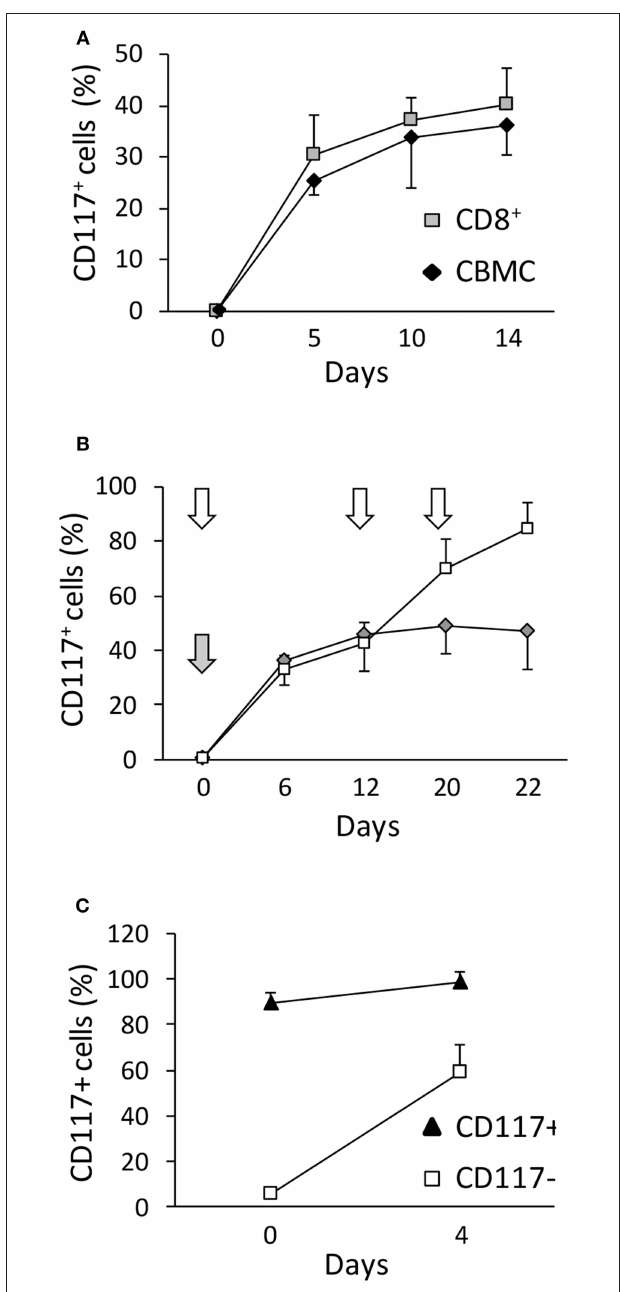
FIGURE 2 | CD117 + is selectively expressed on CD8 + T cells and incremental expression is observed after serial episodes of activation. (A) The kinetics of activation-induced CD117 expression was determined on CBMC or CD8 + T cells purified from UCB by immunomagnetic separation. Gating was set on CD3 + /CD8 + cells. Data are from three independent UCB units. (B) The level of CD117 expression was determined on CD8 + following either a single episode of stimulation at day 0 (gray arrow and diamonds) or after re-stimulation at day 12 and 20 (white arrows and squares). Data are from three independent CBMC samples. (C) CD117 + and CD117 − cells were enriched from purified CD8 + T cells from UCB 12 days after activation and re-stimulated with anti-CD3 plus IL-2. The level of CD117 expression is shown before and 4 days after re-activation. Data are from three independent